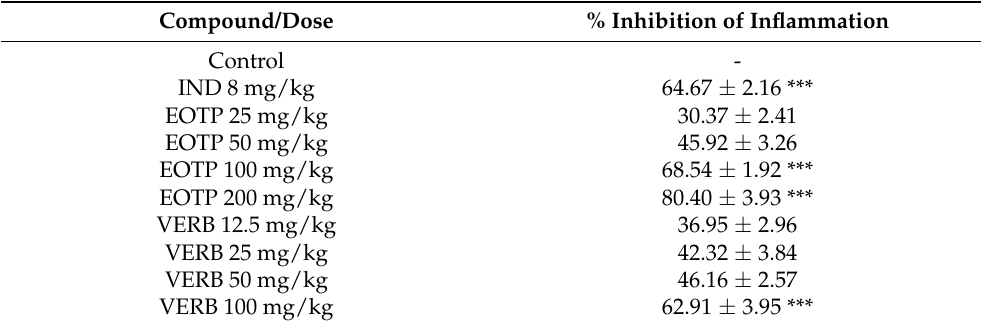
Table 2. Anti-inflammatory activity of EOTP, and VERB, on ear oedema-induced by multiple TPA applications in mice.